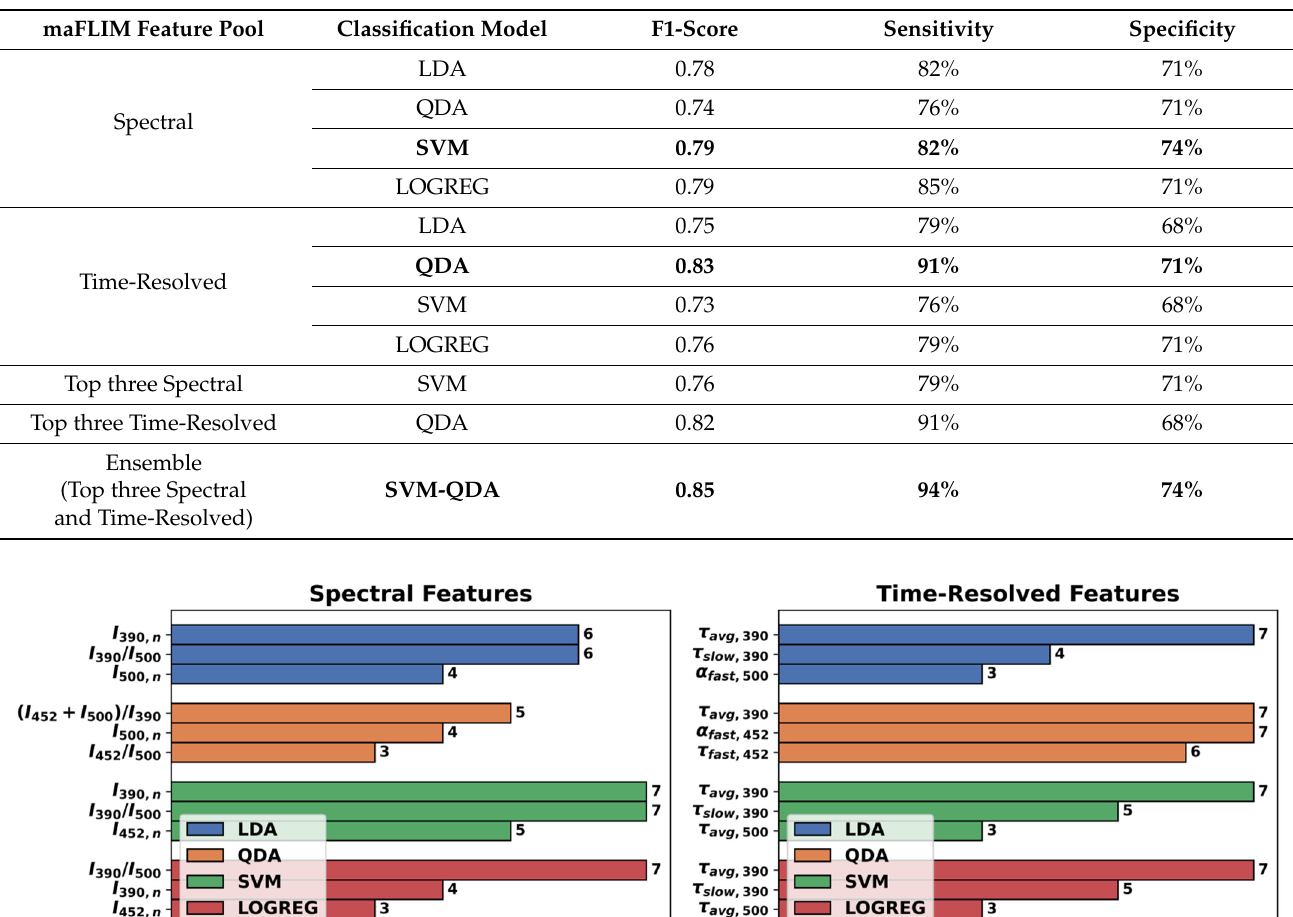
Table 4. Cross-Validation Classification Performance On the Training Set For Each maFLIM Feature Pool and Classifica- tion model.